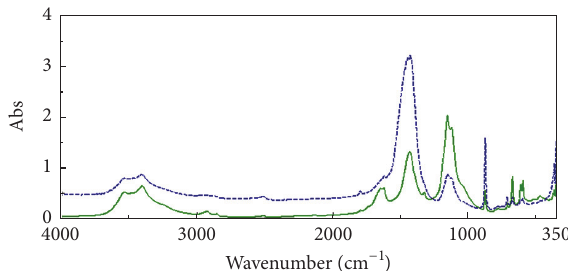
Figure 4: FTIR spectrum of two samples collected from the Imperial Gates: solid line, IG 10; dashed line, IG